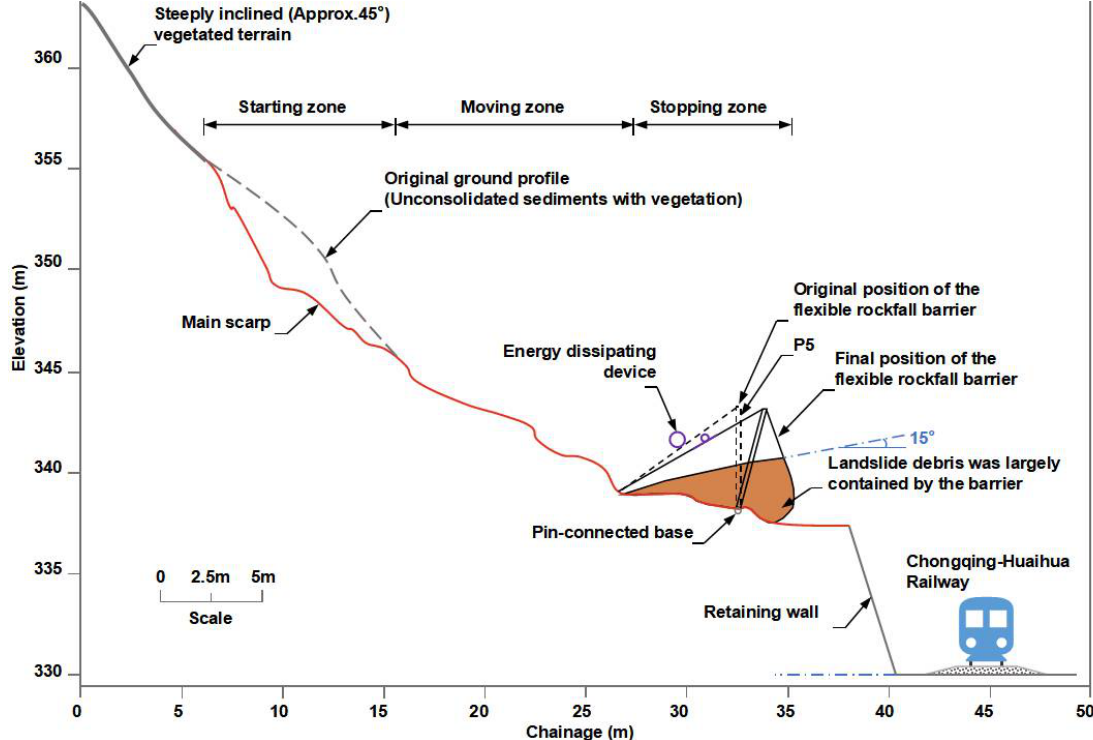
Figure 4. Cross-section along the centerline of the landslide.